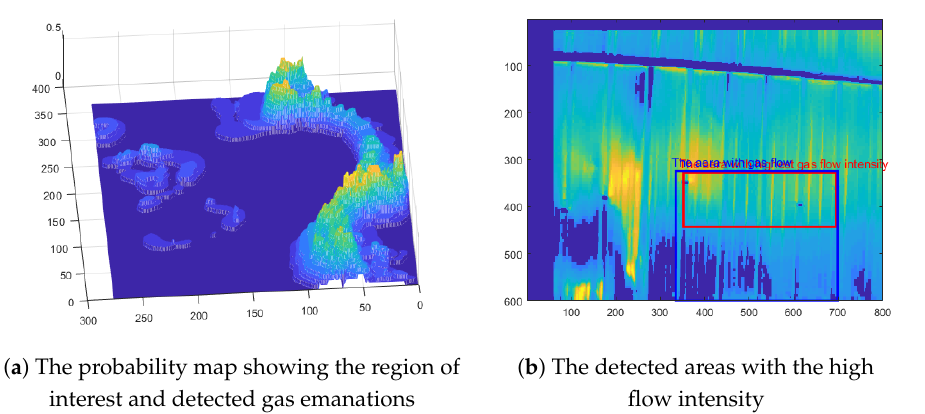
Figure 11. The results of applying the proposed method to the data collected in Experiment C Scenario